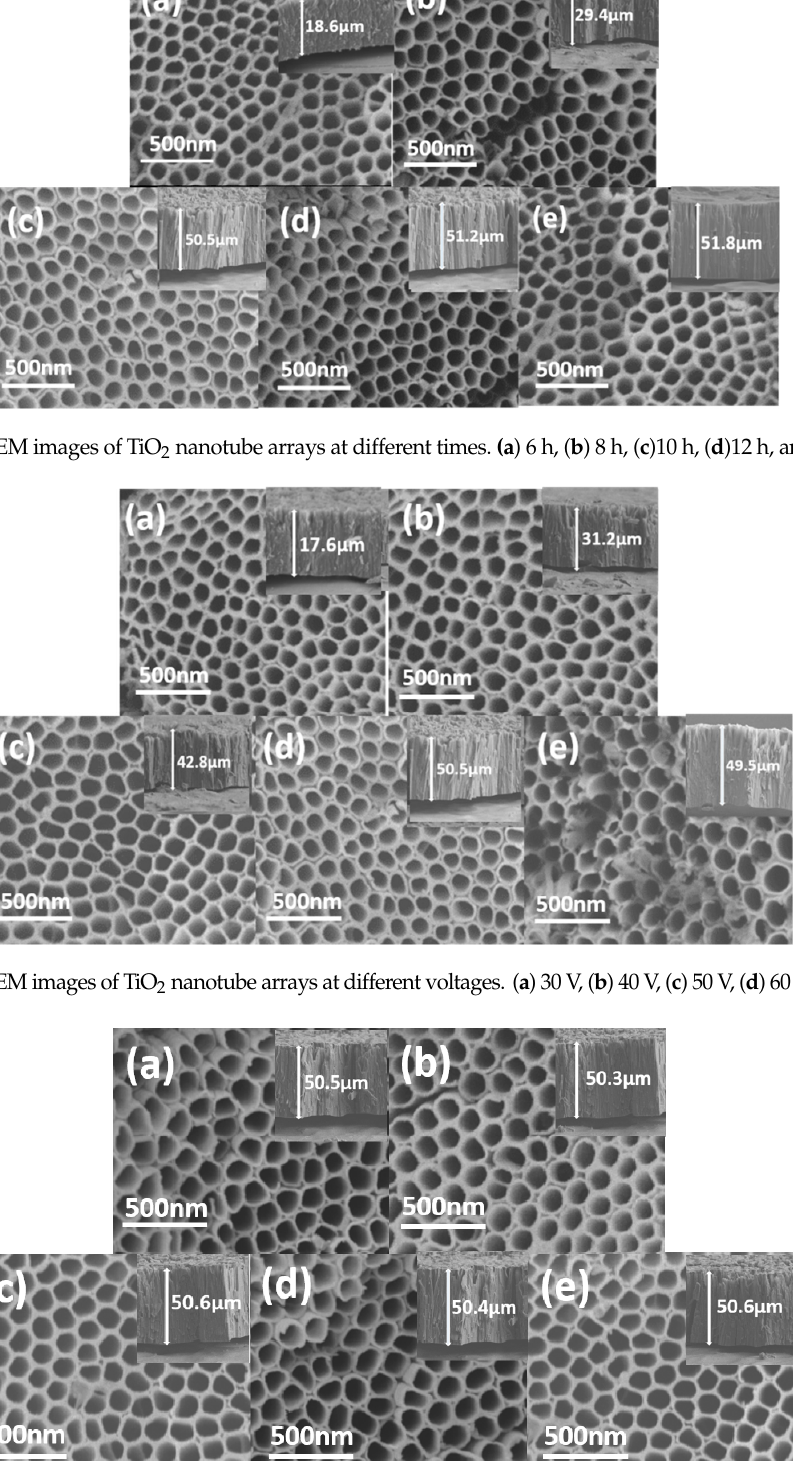
Figure 6. SEM images of samples with different gadolinium concentrations. ( a ) 0.0025 mol/L, ( b ) 0.005 mol/L, ( c ) 0.01 mol/L, ( d ) 0.02 mol/L, and ( e ) 0.04 mol/L ( b ) 0.005 mol / L, ( c ) 0.01 mol / L, ( d ) 0.02 mol / L, and ( e ) 0.04 mol / 2.2.3. TEM